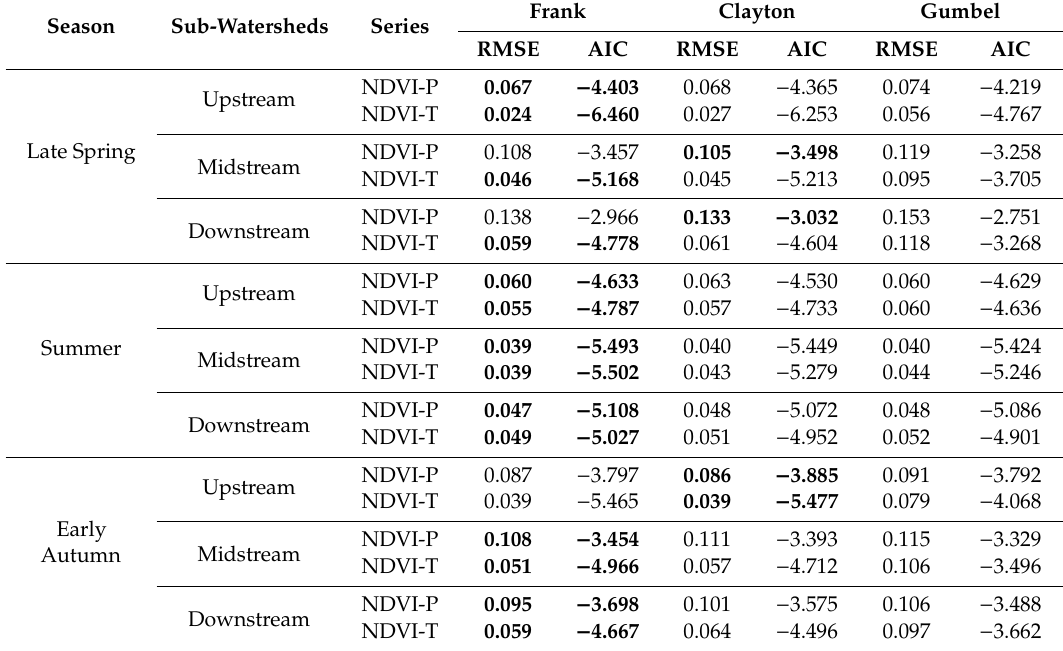
Table 2. The Root-Mean-Square Error (RMSE) and Akaike Information Criterion (AIC) of Frank, Clayton, and Gumbel